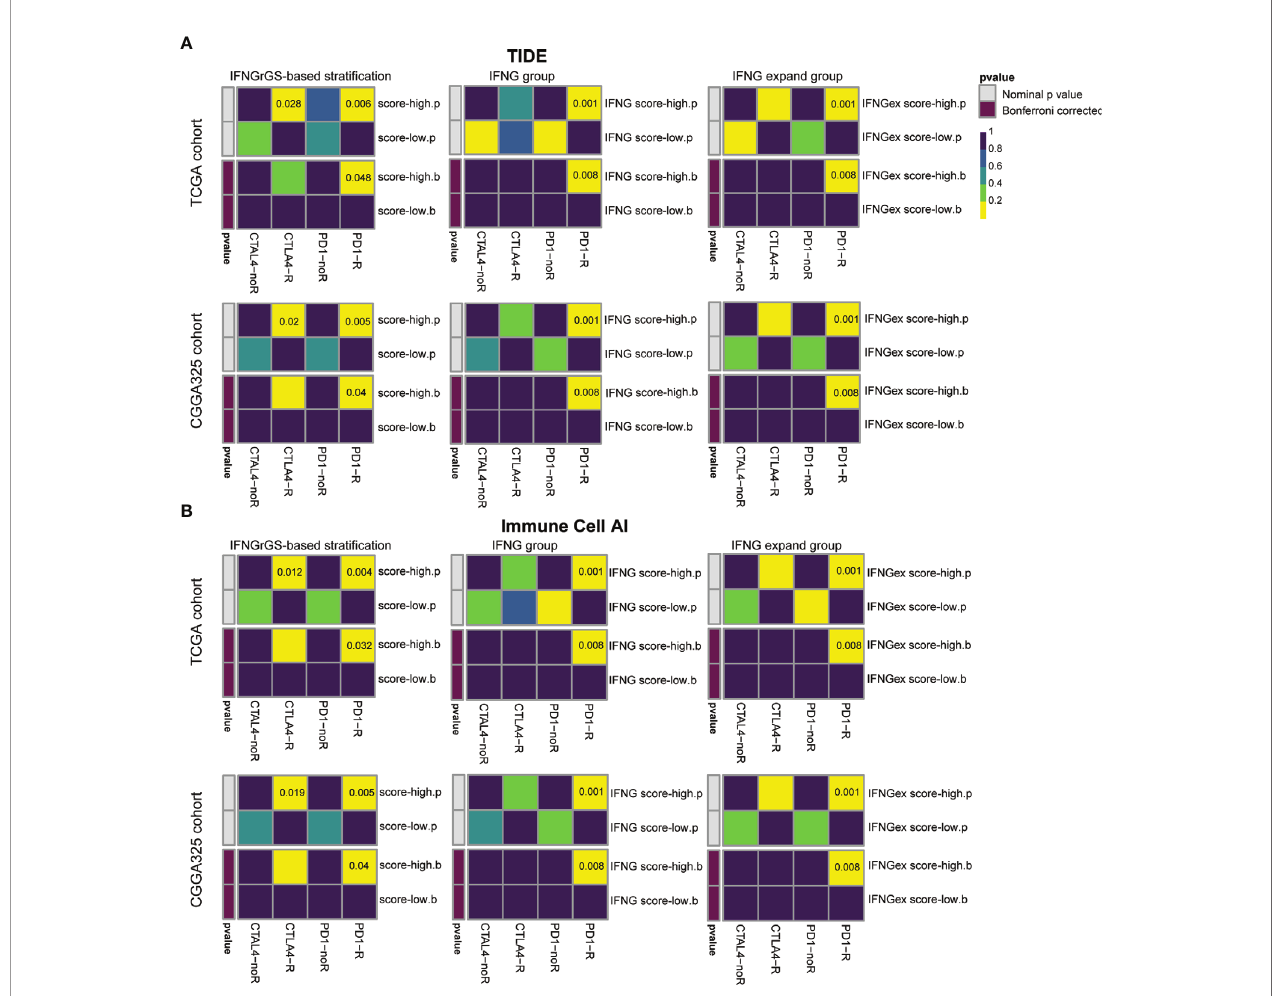
FIGURE 7 | Prediction of the association of IFNGrGS, IFNG gene signature, and IFNG expand gene signature-based strati fi cation with ICB responsiveness. Comparison of the effectiveness of IFNGrGS, IFNG gene signature, and IFNG expand gene signature-based strati fi cation in predicting ICB responsiveness. (A) TIDE and (B)